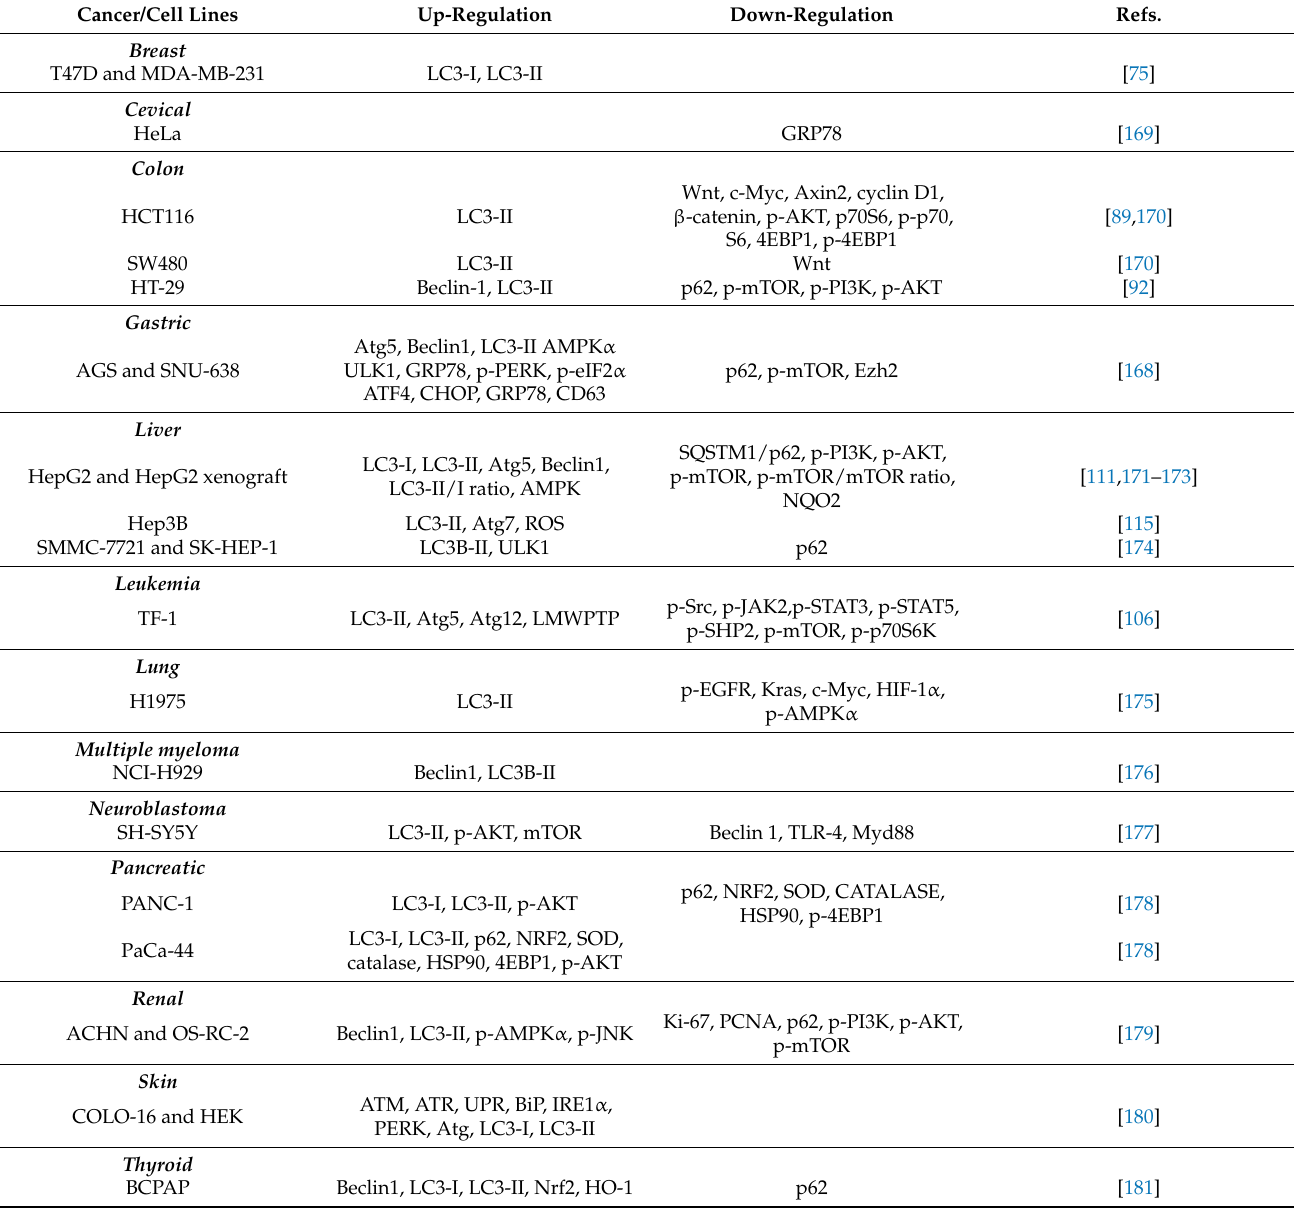
Table 2. Molecular targets of apigenin-induced